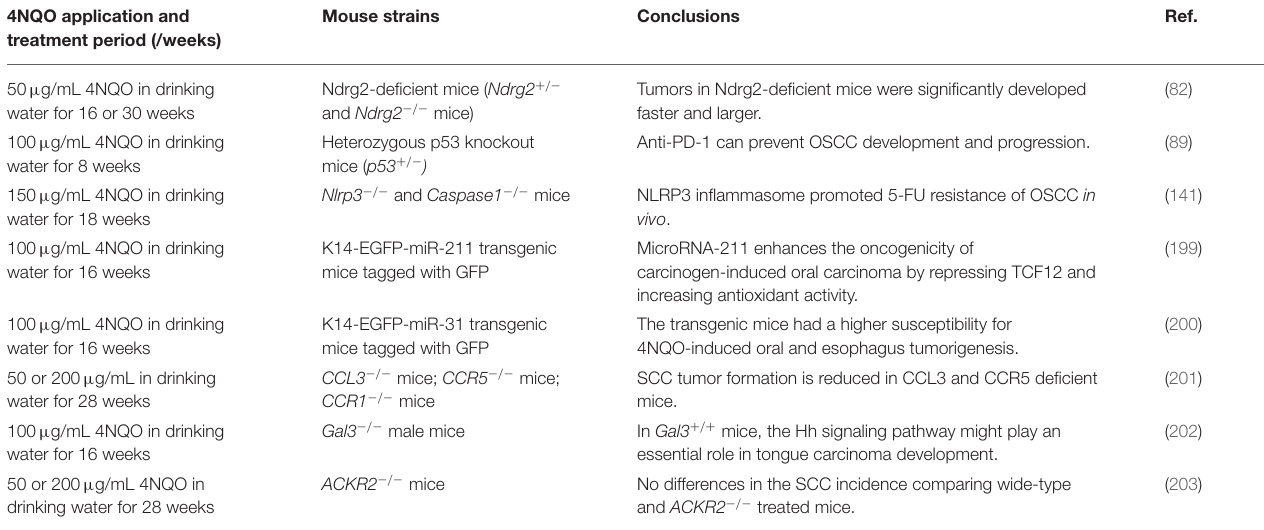
TABLE 6 | 4NQO induced combined with GEMMs for